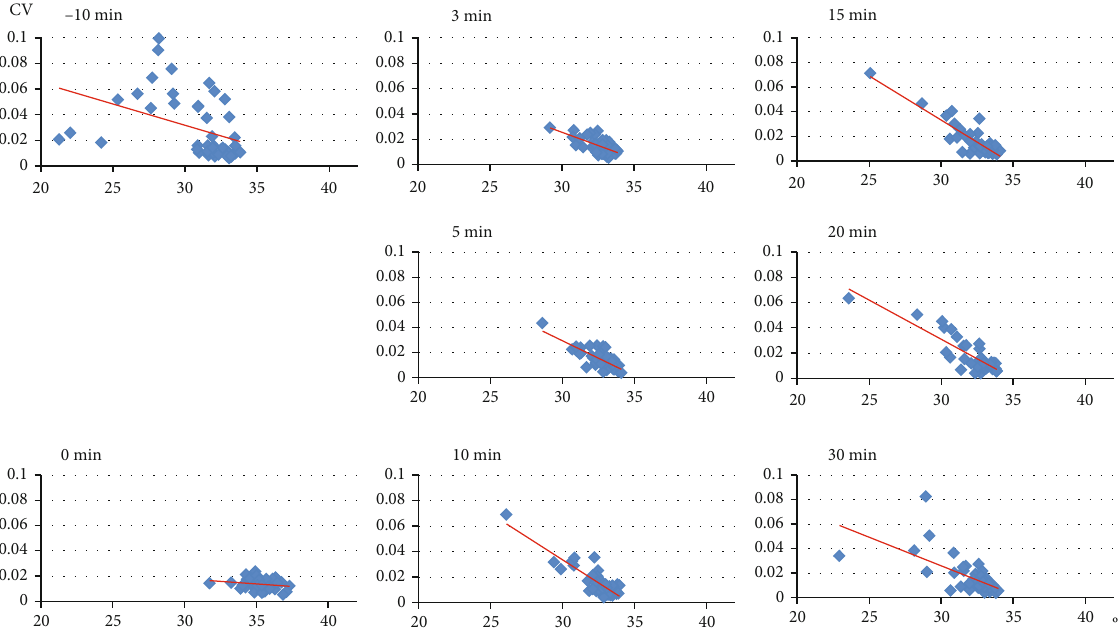
Figure 4: Correlation between m-Temp ( X -axis) and CV ( Y -axis) at each measurement in 47 patients. p < 0 : 01 for all of the measurements. m-Temp: mean nailfold temperature; CV: coe ffi cient of